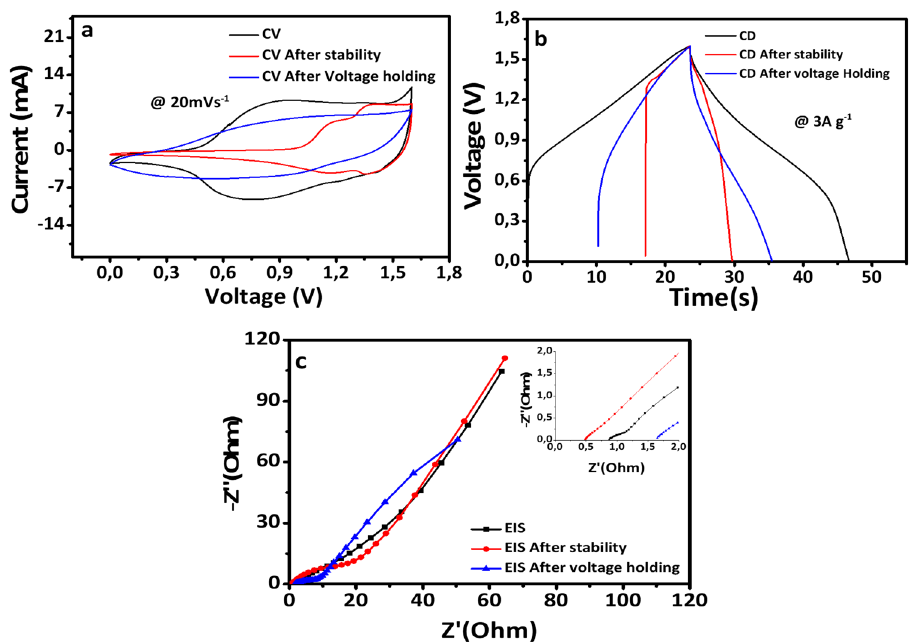
Fig. 11 Electrochemical char- acterisation before and after stability and voltage holding: a CV curves, b CD curves, and c EIS Nyquist